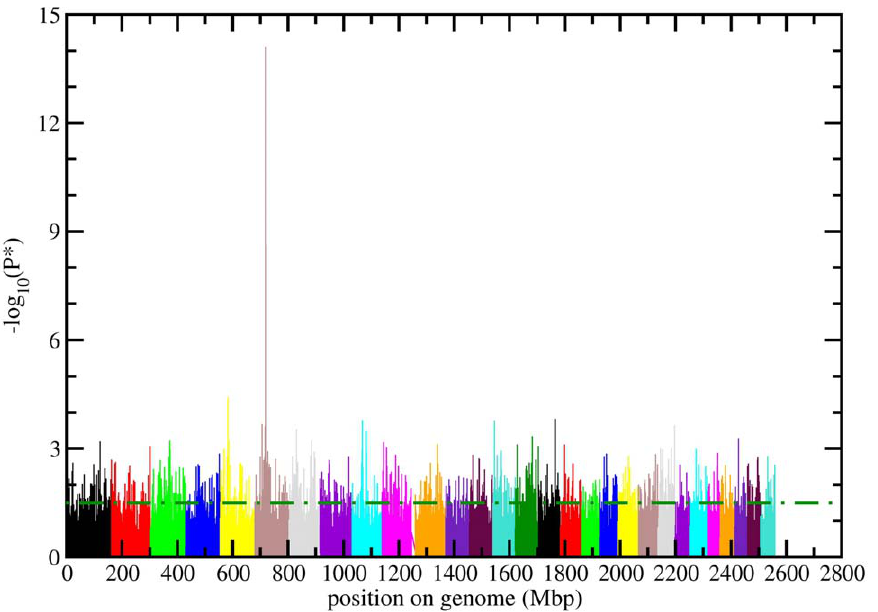
Figure 3. Descriptive histograms for the reduced population of 247 sires used for additional genotyping of SNPs within the LAP3 , NCAPG and LCORL genes after the GWAS. Left Panel: histograms of EBVs for direct calving ease distributed in five equally spaced classes. Right panel: histogram of kinship coefficients between sires in five equally spaced classes. In both panels, the number of sires belonging to each class is plotted as a function of classes.